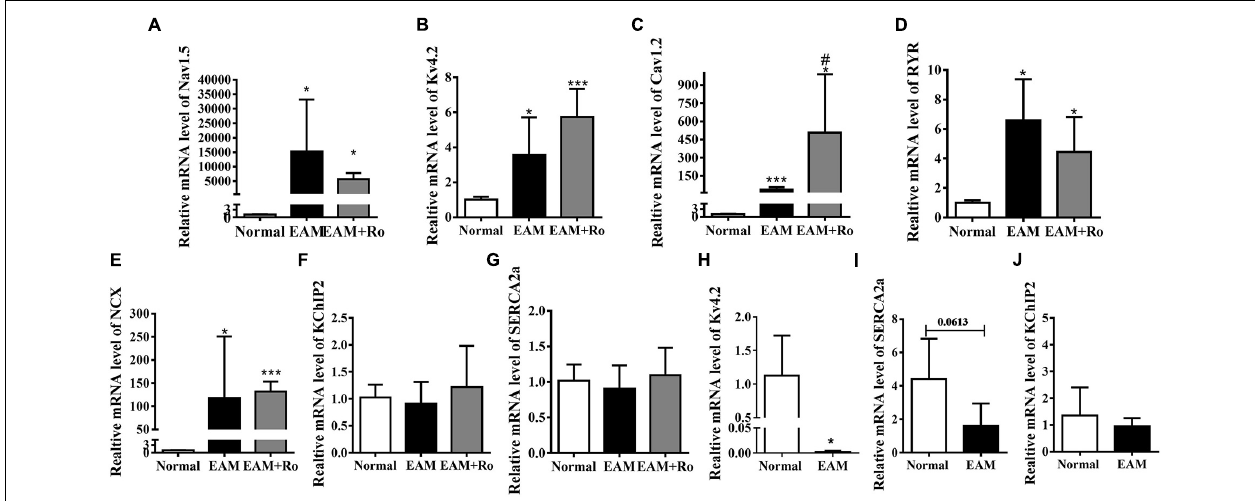
FIGURE 5 | mRNA expression of ion channels and related regulatory proteins in normal, EAM, and Ro-32-0432-treated EAM rat hearts. (A–G) Relative mRNA expressions of Nav1.5, Kv4.2, Cav1.2, RYR, NCX, KchIP2, and SERCA2a. mRNA expressions of Kv4.2 and Cav1.2 were significantly increased in EAM rats, whereas Ro-32-0432 treatment did not have a significant reduction or even a slight increase (Cav1.2) compared with EAM rats. mRNA expressions of KchIP and SERCA2a had no difference in the hearts of normal, EAM, and Ro-32-0432-treated EAM rat. (H–J) mRNA expressions of Kv4.2, SERCA2a, and KchIP2 in the left ventricular wall. Error bars represent mean ± SD , n = 5 for each group. * p < 0.05 vs. control; *** p < 0.001 vs. control; # p < 0.05 vs.